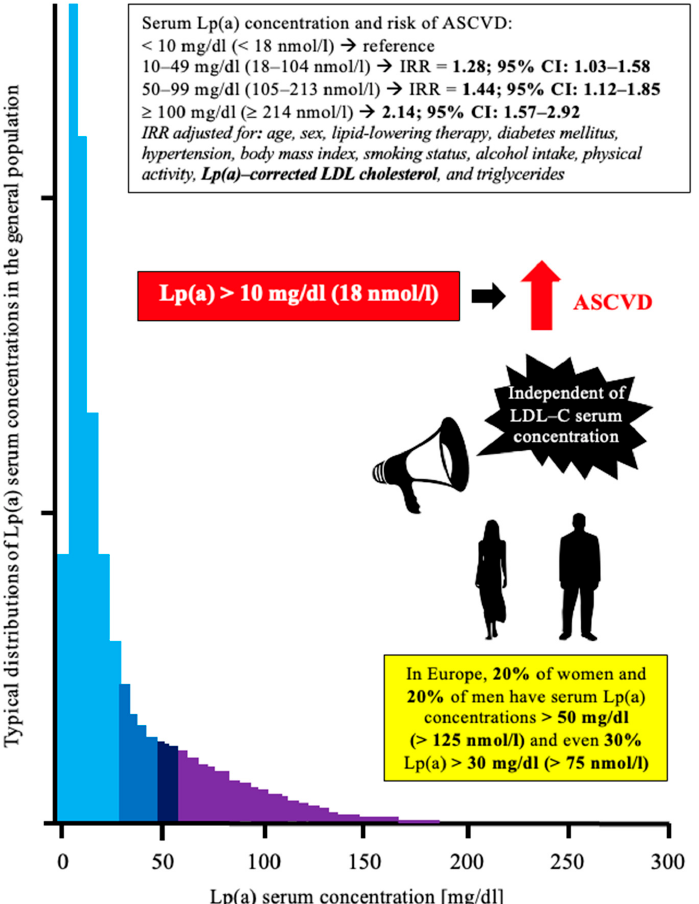
Figure 1. Distribution of serum Lp(a) concentrations in the general population and its relationship to the risk of ASCVD. Prepared on the basis of [11–13]. ASCVD—atherosclerotic cardiovascular disease; LDL-C—low density lipoprotein cholesterol; Lp(a)—lipoprotein (a). Lp(a) is an independent CVD risk factor, as evidenced by the fact that up to 30% of patients with familial hypercholesterolaemia and/or acute coronary syndrome may have elevated levels of this lipoprotein at the desired LDL-C levels [14]. Based on the serum Lp(a) concentration, the cardiovascular risk can be determined: 30–50 mg/dL (75–125 nmol/L) moderate risk; >50 mg/dL (125 nmol/L) high risk; >180 mg/dL (450 nmol/L) very high cardiovascular risk [5]. Despite this, the latest EAS guidelines still suggest a cut-off point for Lp(a) >50 nmol/L [15]. Please note that according to all recommendations, we should strive to determine Lp(a) in nmol/L, because this determines not the mass of par- ticles, but their number [5,15]. In a study by Rikhi et al., including 4585 subjects from Multi-Ethnic Study of Ather- osclerosis (MESA), with 13.4 years of follow-up, it was shown that when Lp(a) was ele- vated, the risk of ASCVD events increased, regardless of baseline LDL-C [9]. A study by Afshar et al. involving 2606 Framingham Offspring participants assessed the correlation between serum Lp(a) and LDL-C concentrations and the risk of ASCVD. It was also found that elevated serum Lp(a) concentrations, regardless of LDL-C, were associated with an